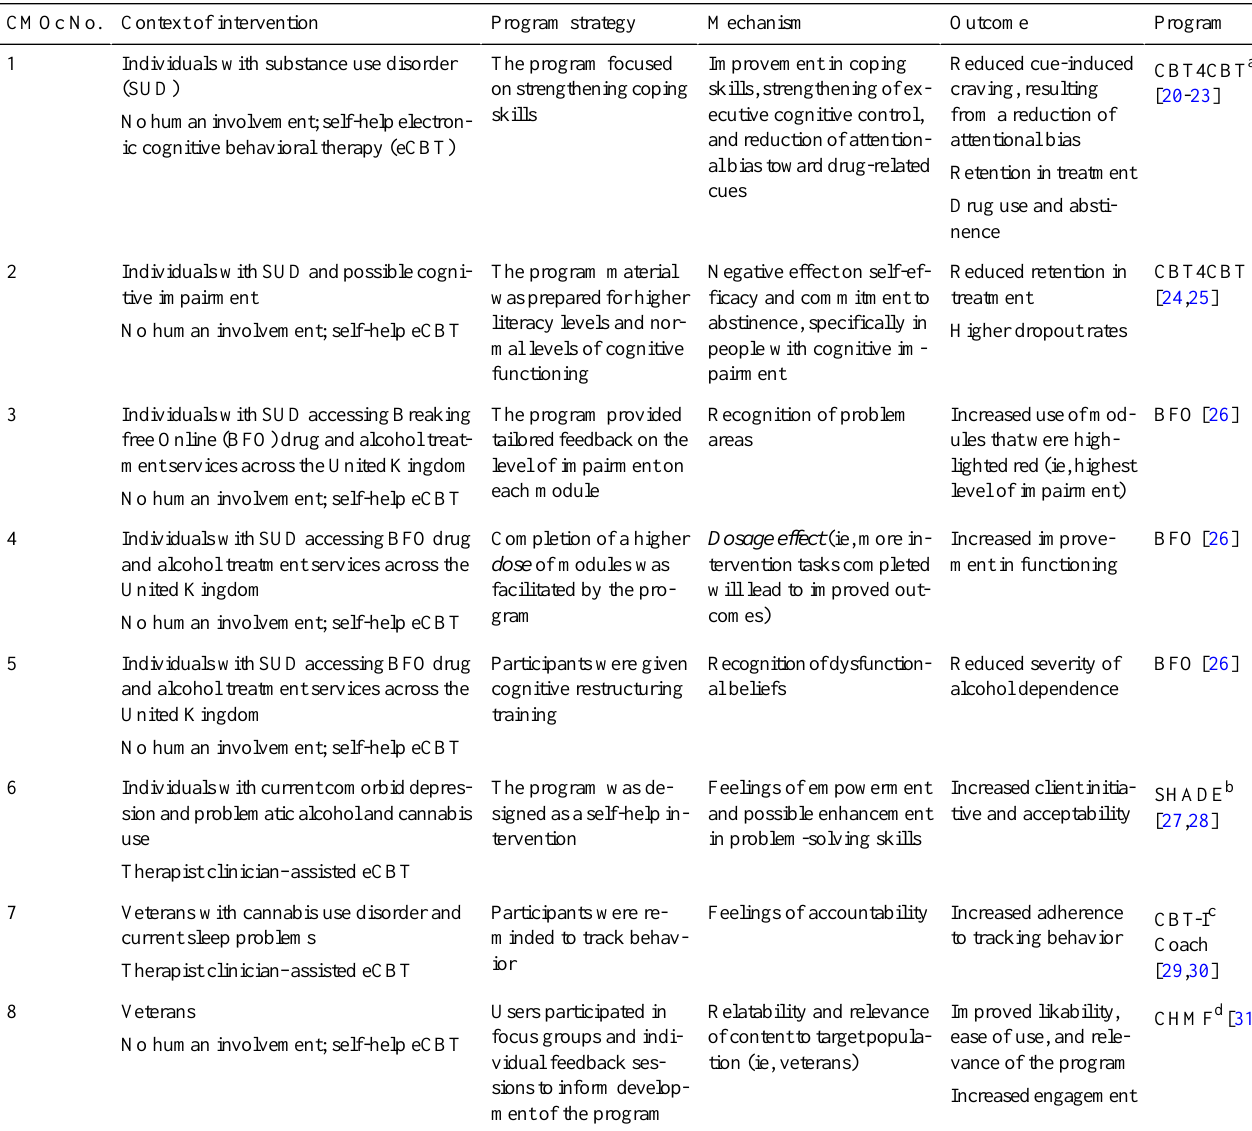
Table 1. Summary of components of the eight Context-Mechanism-Outcome configurations (CMOcs).